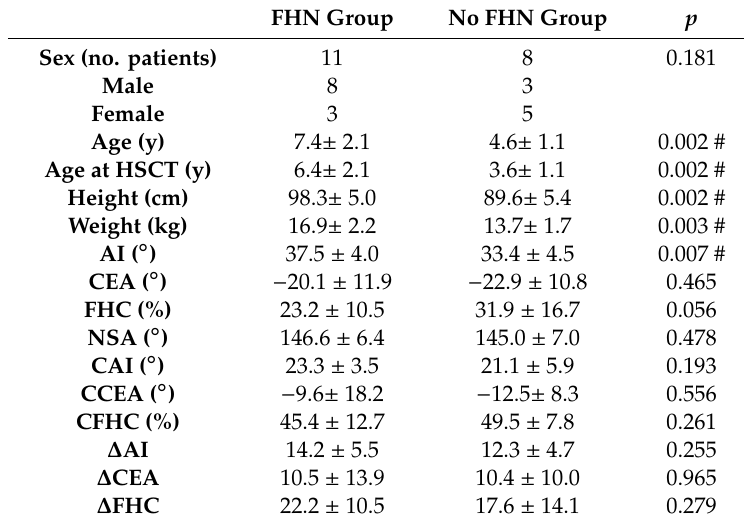
Table 3. Comparison of femoral head osteonecrosis (FHN) and non- FHN patients. FHN Group No FHN Group p Sex (no. patients) 11 8